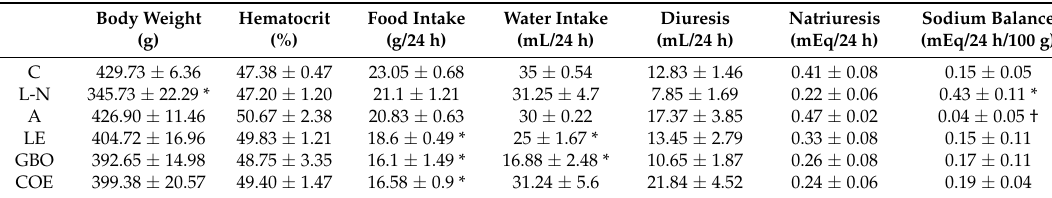
Table 1. Body weight and hematocrit values in the experimental